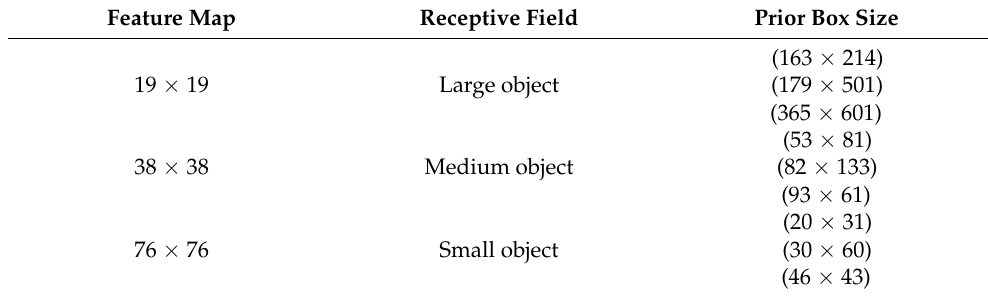
Table 3. The size of prior